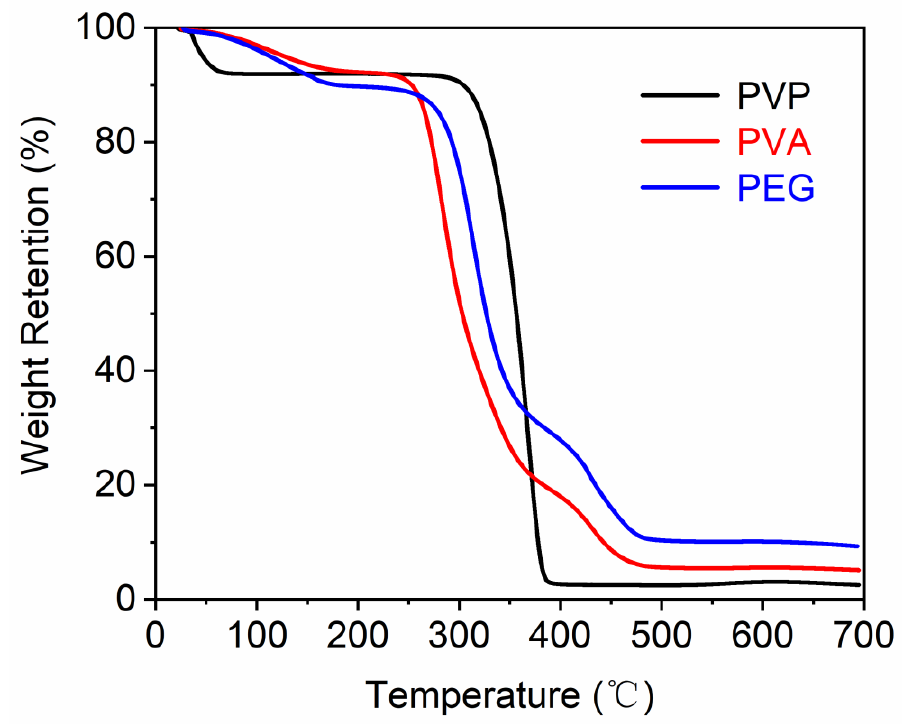
Figure 2. TG curves of PVP, PVA, and